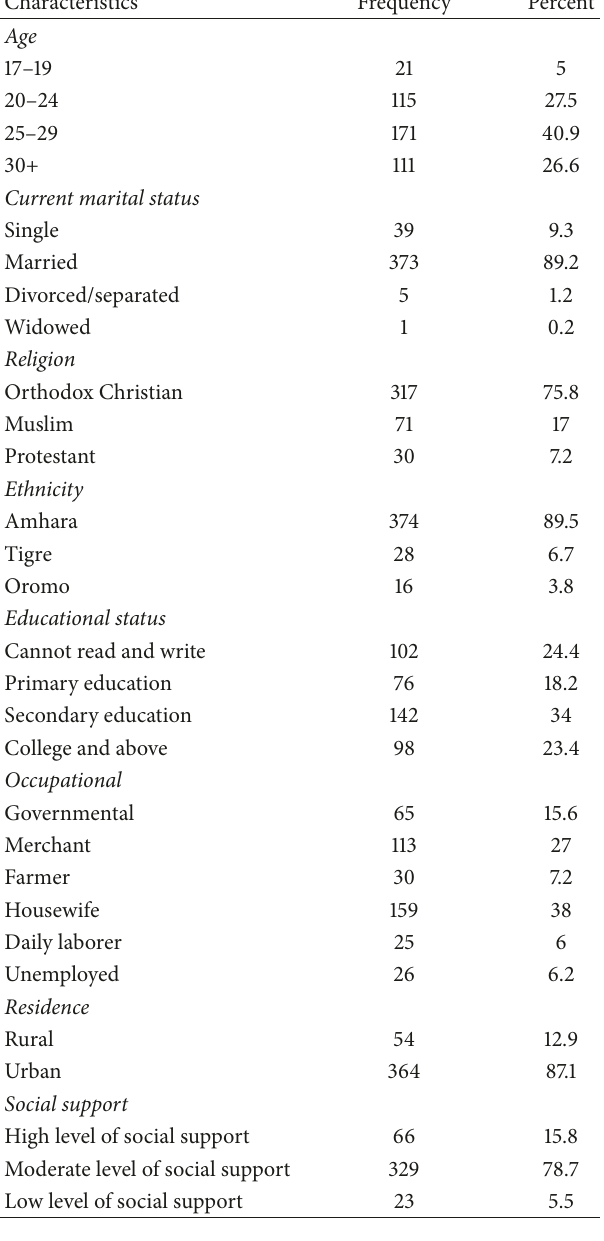
Table 1: Sociodemographic characteristics of participants in Gondar town, 2015 (𝑛 = 418) .